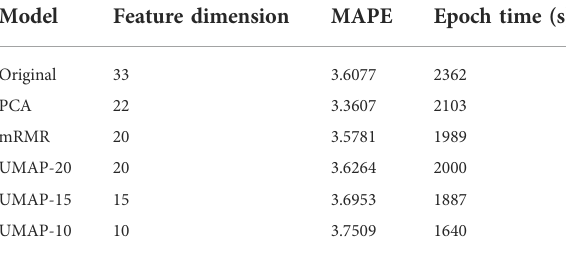
TABLE 2 Different feature extraction and corresponding statistical data under TCN-NBeats model.